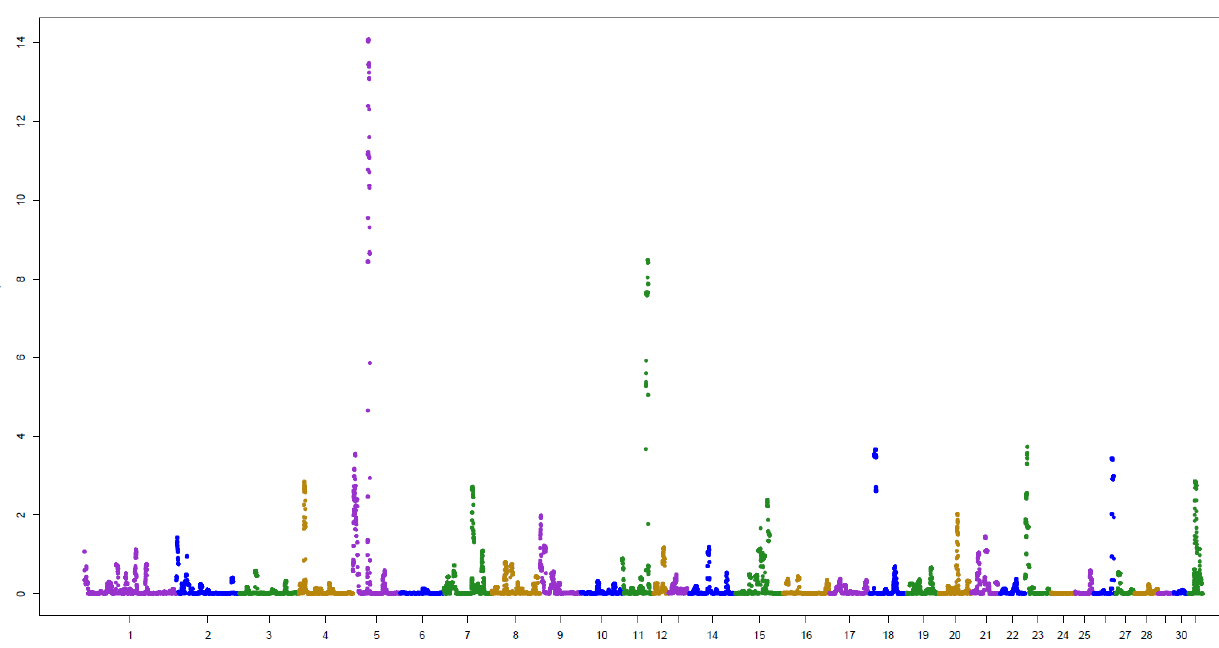
Figure 4. Manhattan plot of hair whorl number on the left side of the neck of Quarter Horses. The y-axis indicates the proportion of variance explained by windows of 100 adjacent SNPs. The chromosomes are given on the x-axis.